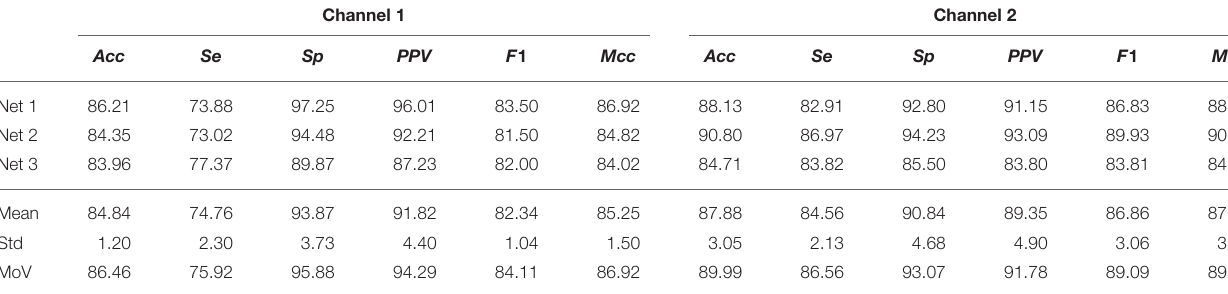
TABLE 4 | ECM-images classification performance on AFDB.